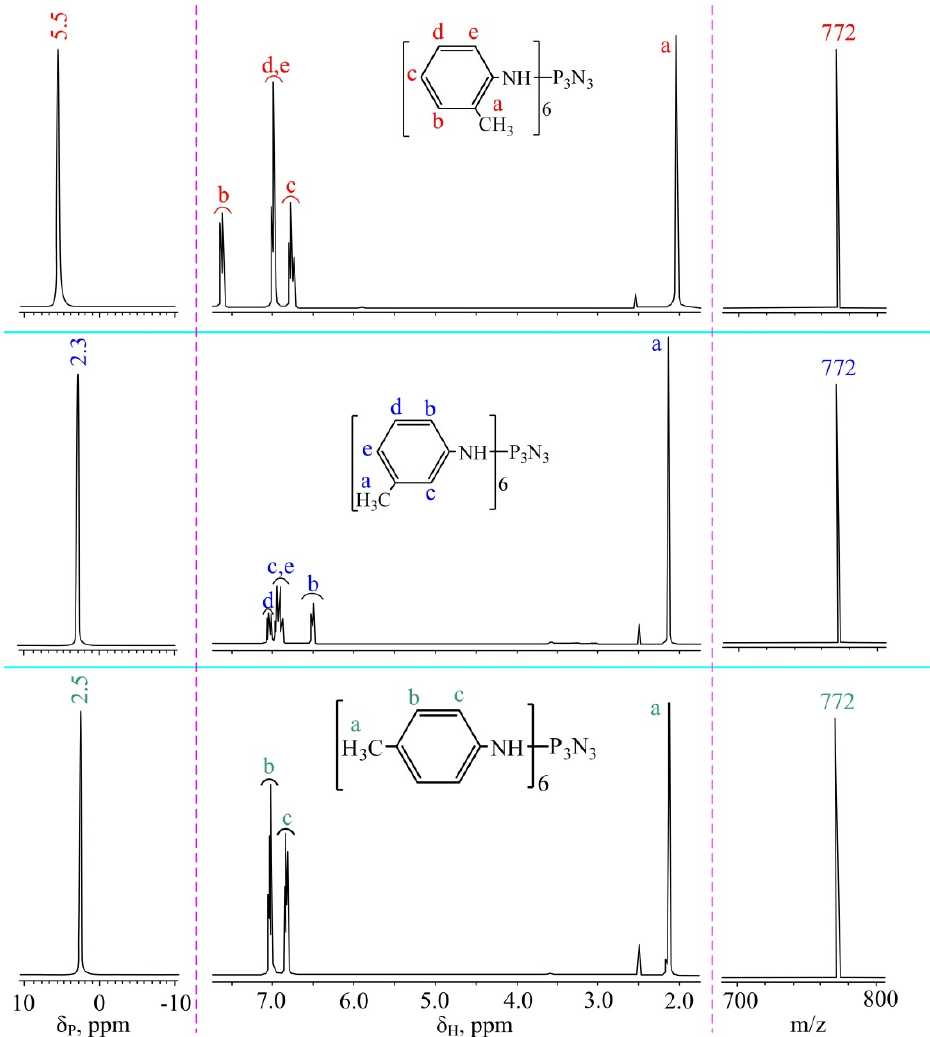
Figure 2. 31 P ( left ), 1 H (in the middle ), and MALDI-TOF ( right ) spectra o-AAP, m-AAP, and p-AAP.